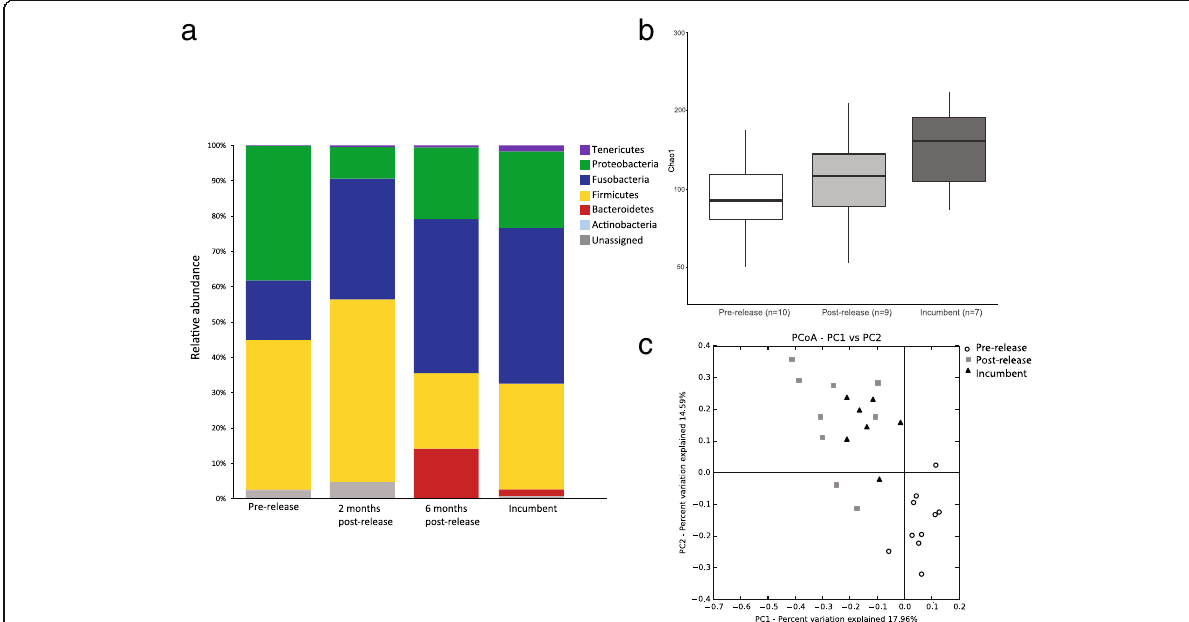
Fig. 2 Composition and diversity of gut microbiome of released ( n = 5) and wild incumbent devils ( n = 7) from the captive-to-wild translocation (Maria Island release) at various time points. a Bar chart showing the phylum level composition of the gut microbiome; b Whisker-box plot showing the gut microbiome alpha diversity ( Chao 1 ) of released ( n = 5) and wild incumbent devils ( n = 7). Black horizontal lines are the median values; the lower and upper bound of boxes represent the 25th and 75th percentiles, respectively; c Principal coordinates analysis (PCoA) plot based on the unweighted UniFrac distance matrix, depicting patterns of beta diversity from the gut microbiome of release devils before and after release (pre- and post-release), and the wild incumbent devils on Maria Island (incumbent). Points that cluster together on the ordination have bacterial communities that are more